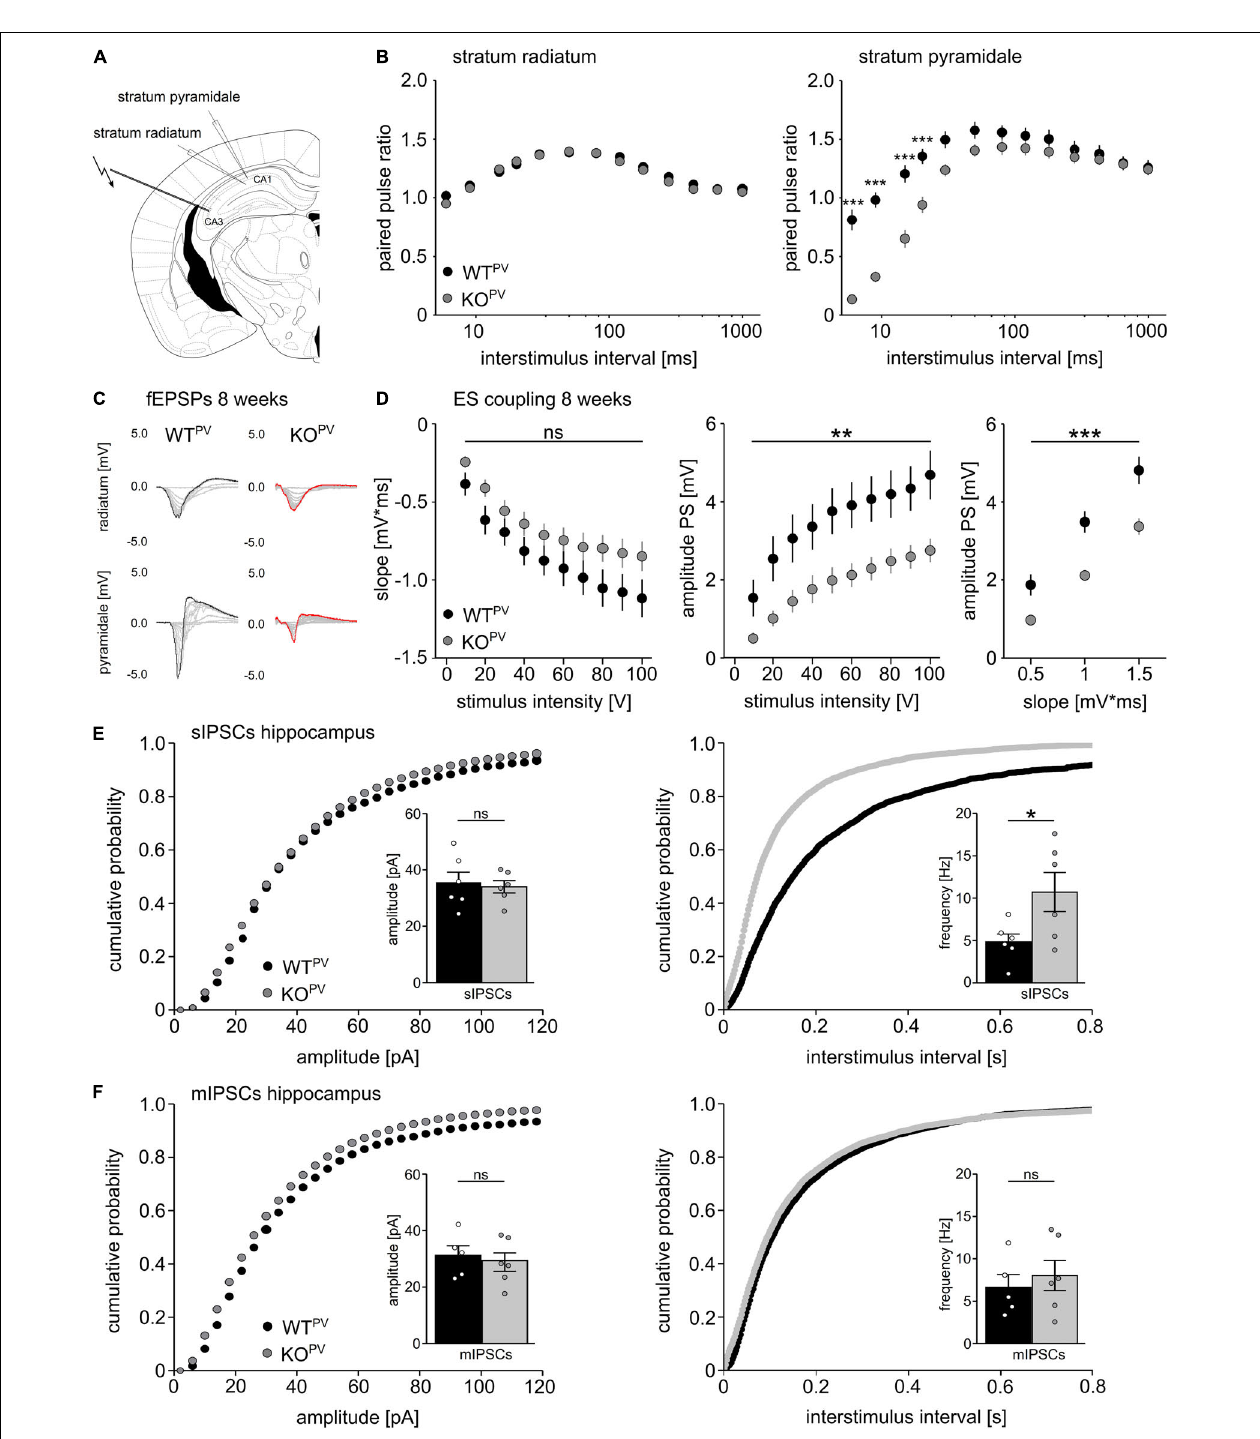
FIGURE 4 | Disinhibition of PV-INs upon disruption of KCC2. (A) Position of stimulus and recording electrodes for field recordings in the stratum pyramidale and radiatum of CA1. (B) Paired-pulse ratios are reduced in the stratum pyramidale ( n = 28/24 cells from N = 9/9 mice), but not in the stratum radiatum ( n = 35/34 cells from N = 11/11 mice) of KCC2 KO PV mice (2-way ANOVA repeated measure; Bonferroni post-test; *** p < 0.0001). (C) Representative examples of fESPs recorded in the stratum radiatum and stratum pyramidale in KCC2 WT PV and KCC2 KO PV mice. (D) E-S-coupling is diminished in 8-week-old KCC2 KO PV mice ( n = 14/17 slices from N = 4/4 mice, 2-way ANOVA repeated measure; Bonferroni post-test; ** p = 0.008; *** p < 0.0001). (E) The frequency, but not the amplitude of spontaneous inhibitory post synaptic currents (sIPSCs) is increased in CA1 pyramidal neurons in KCC2 KO PV mice ( N = 6/6 mice, unpaired Student’s t -test; Kolmogorov-Smirnov test; ns not significant; * p = 0.0398). (F) Miniature inhibitory postsynaptic currents (mIPSCs) upon tetrodotoxin (TTX) inhibition of spontaneous network driven events are not changed in 8-week-old KCC2 KO PV mice ( N = 6/6 mice; unpaired Student’s t -test; Kolmogorov-Smirnov test; ns not